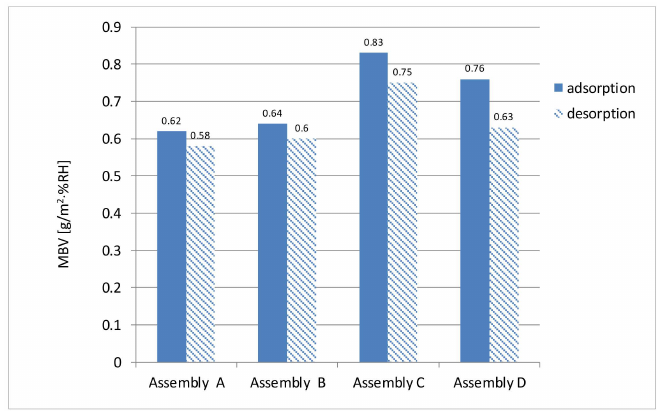
Figure 6. Moisture bu ff er values for individual